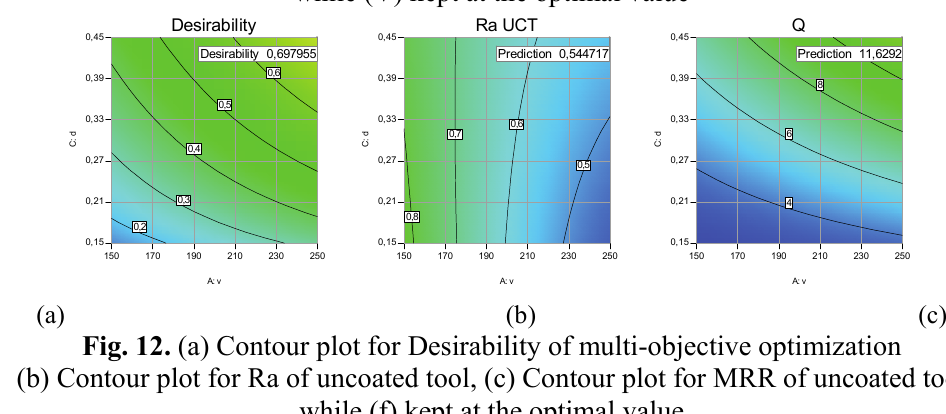
Fig. 11. (a) Contour plot for Desirability of multi-objective optimization (b) Contour plot for Ra of uncoated tool, (c) Contour plot for MRR of uncoated tool while (V) kept at the optimal value